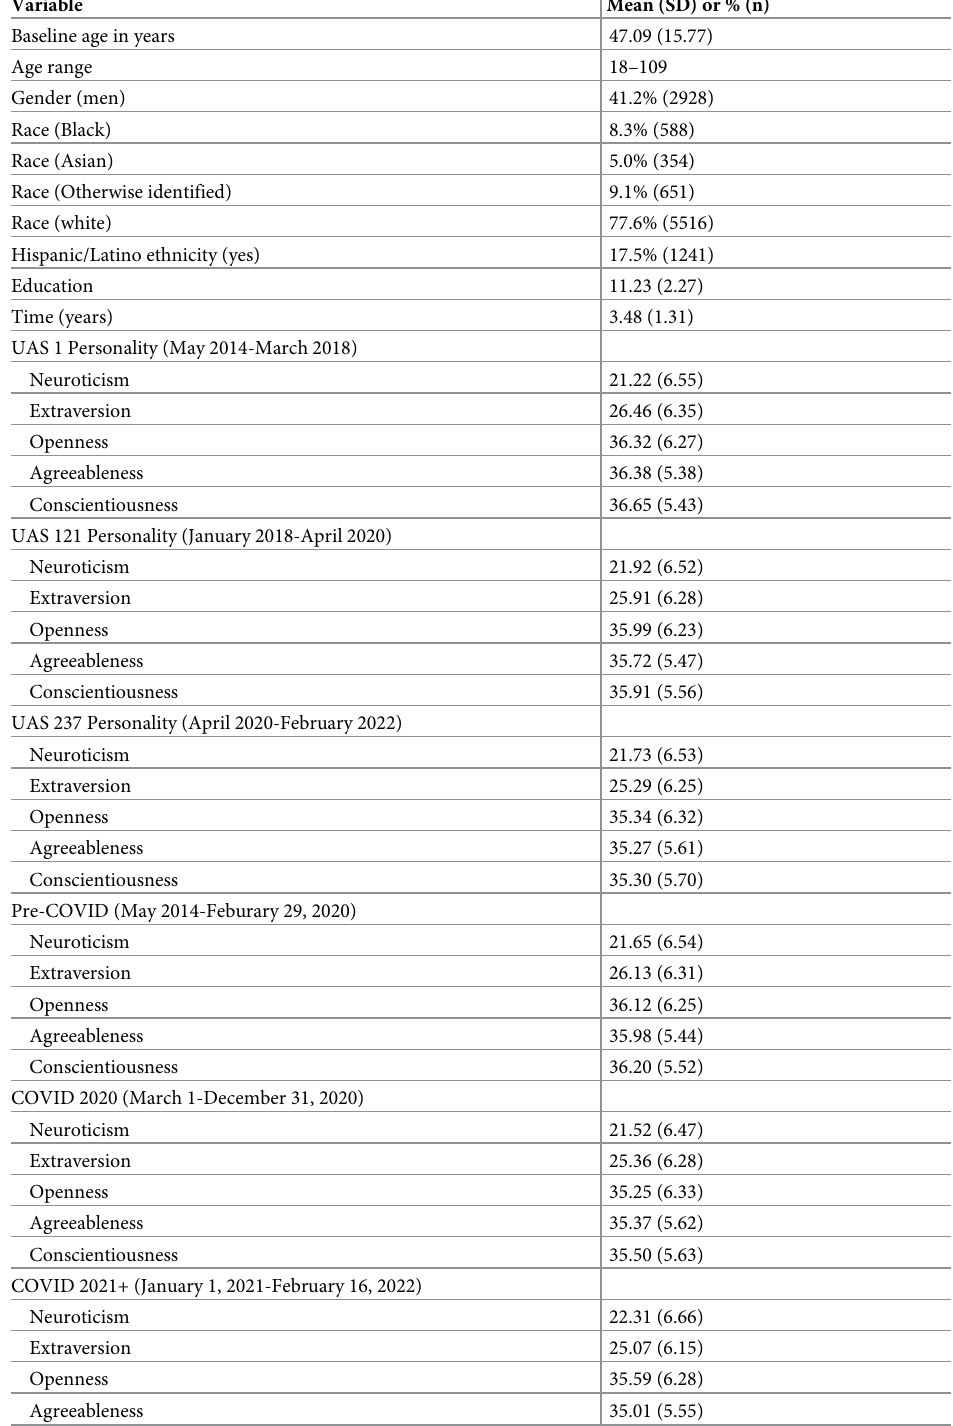
Table 1. Descriptive statistics (mean [standard deviation] or % [sample size]) for study variables analyzed in the current